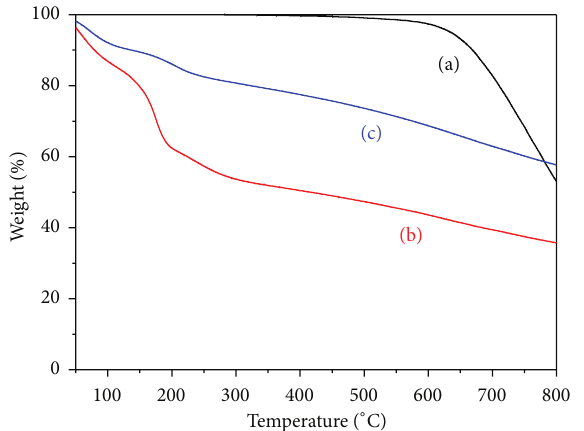
Figure 2: TGA of (a) graphite, (b) XGO, and (c) RGO.